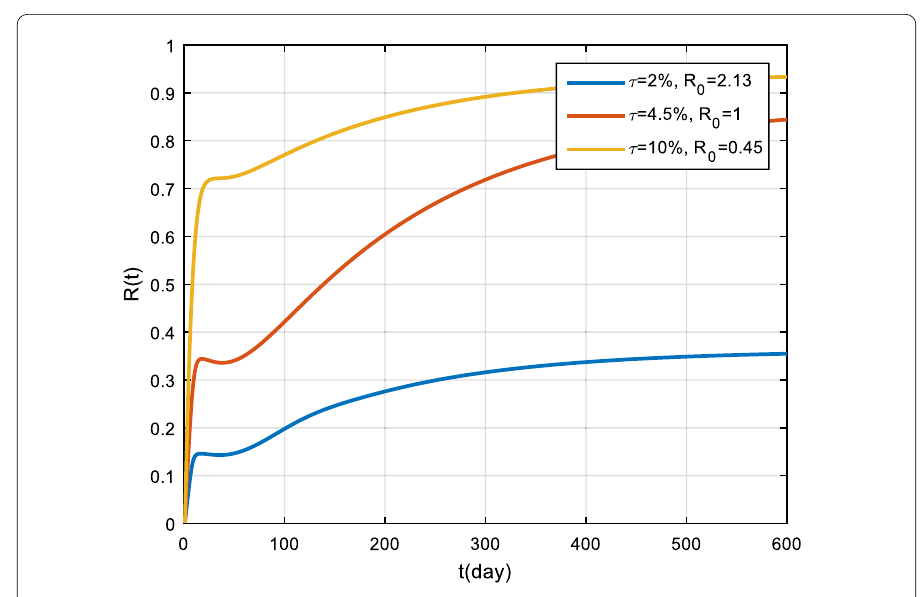
Figure 16 Variation in the number of recovered population for different values of